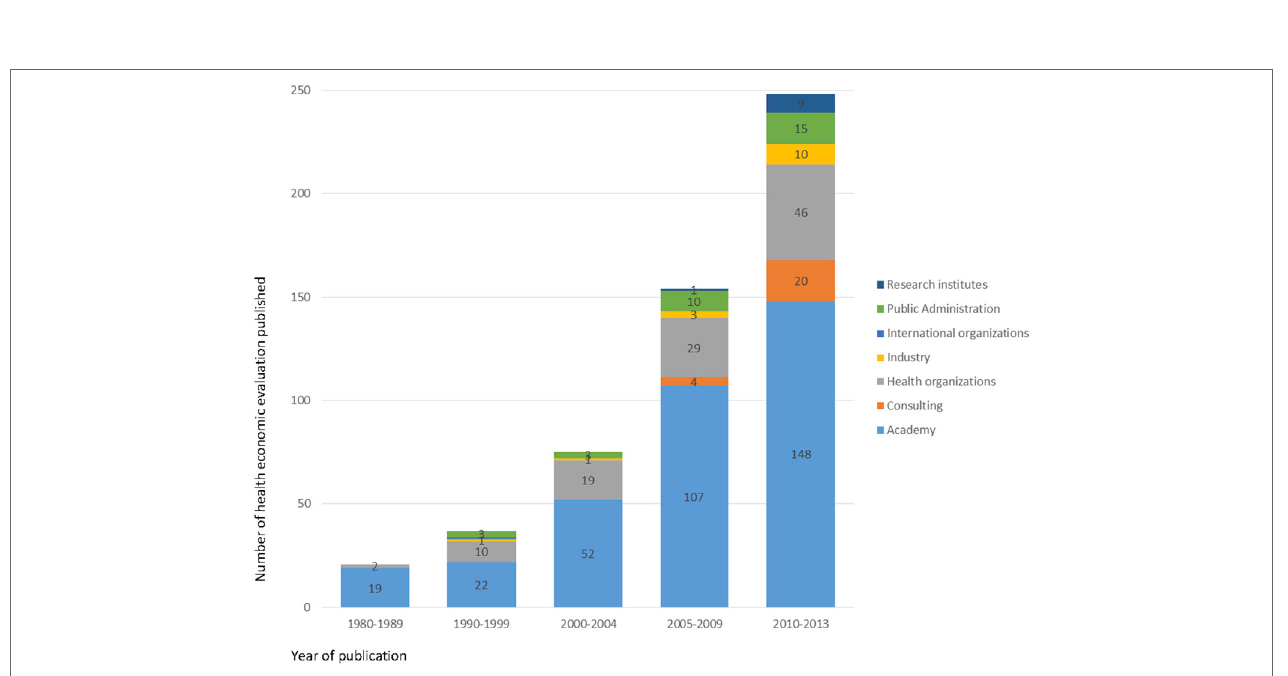
FiGURe 4 | Number of health economic evaluation studies in Brazil, by first author affiliation, 1980–2013.